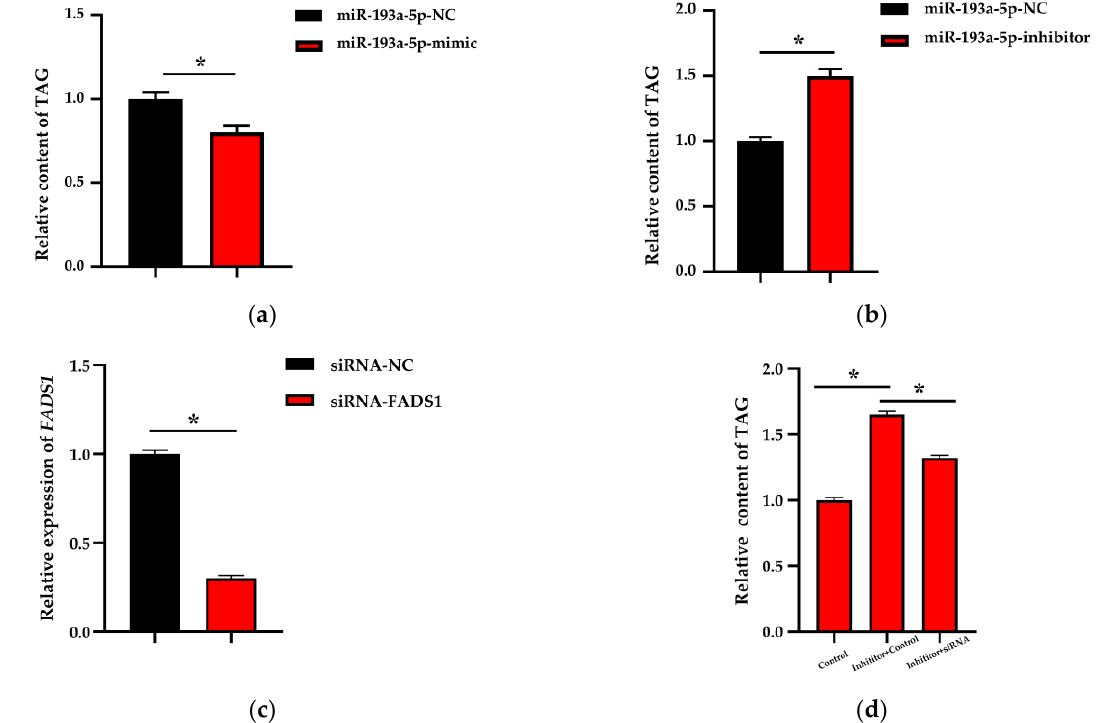
Figure 6. The relative content of triglycerides (TAG) in BMECs after transfecting with the ( a ) mimic and ( b ) inhibitor ( n = 9). ( c ) The relative mRNA expression of FADS1 after transfecting siRNA for 48 h. ( d ) The relative content of TAG in BMECs after co-transfecting with siRNA and the inhibitor of miRNA-193a-5p for 48 h. NC represents the negative control. Data are presented as mean ± standard error (SE). * represents p < 0.05, indicating significant differences between the groups.